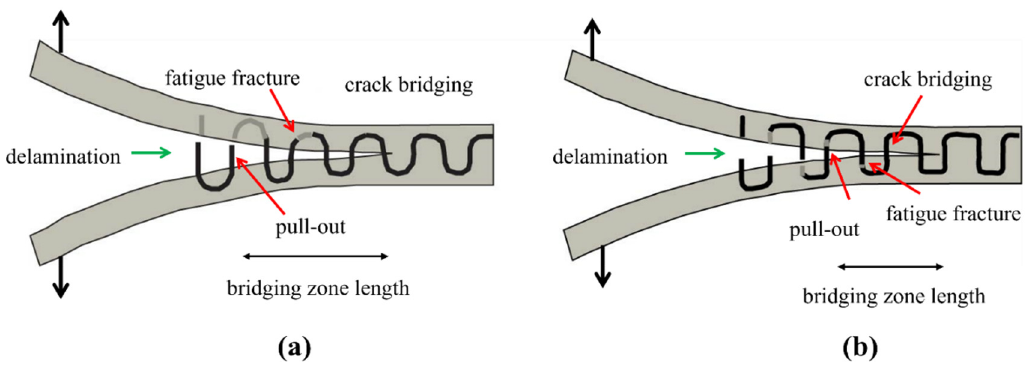
Figure 26. Schematic diagram showing the sideview of DCB specimen subjected to mode I fatigue ( a ) steel z-filaments ( b ) carbon fibrez- filaments.